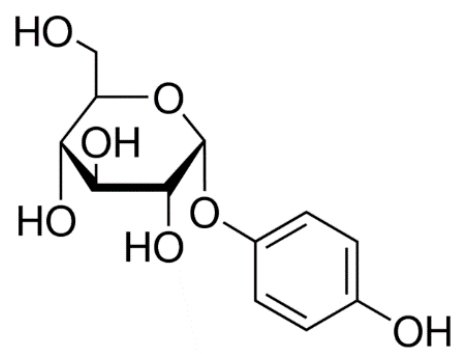
Figure 2. Arbutin structure. Figure 2. Arbutin